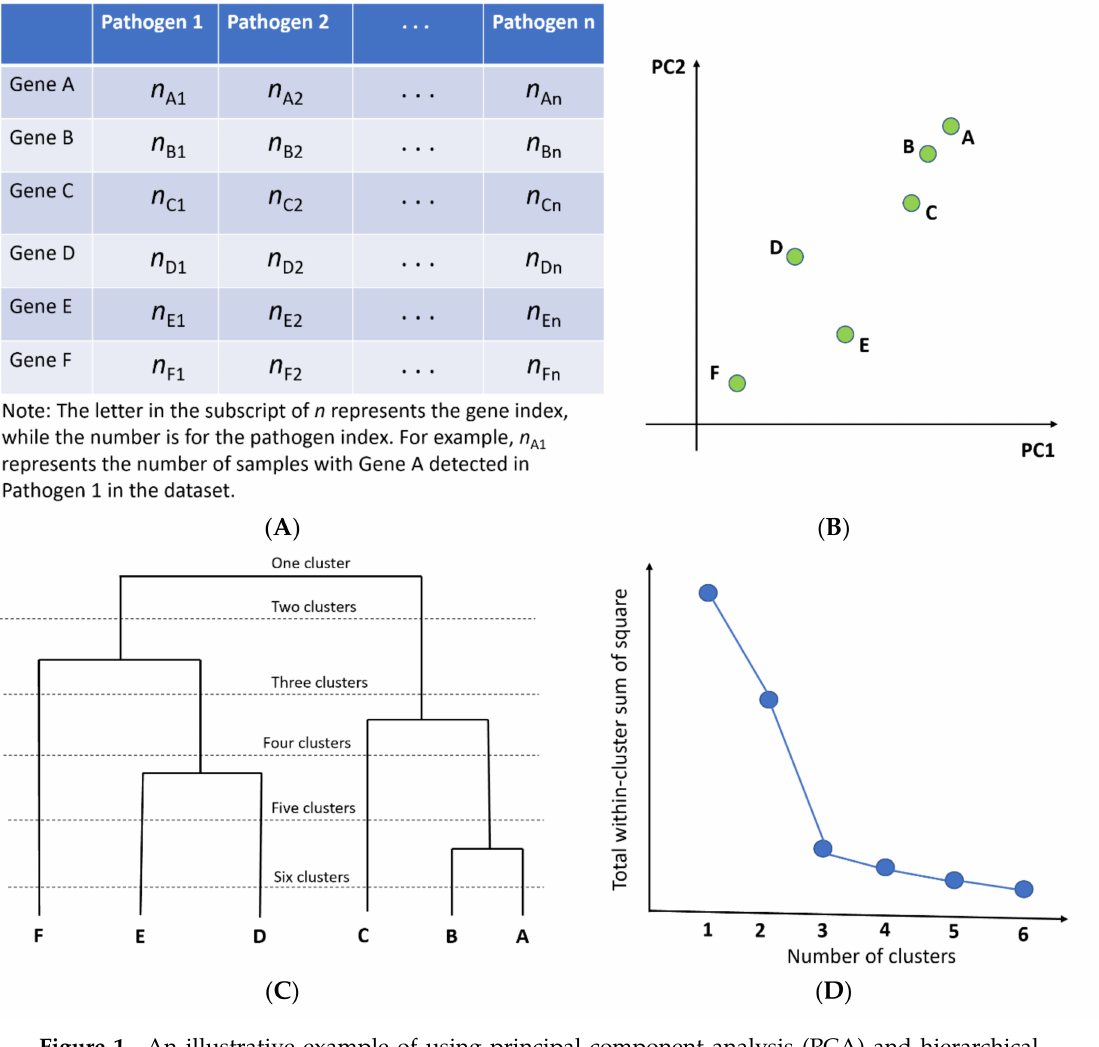
Figure 1. An illustrative example of using principal component analysis (PCA) and hierarchical clustering to identify important virulence genes: ( A ) a matrix was constructed with elements representing the number of the samples in which the gene in each row was detected in the pathogens in the columns; ( B ) genes from the high-dimensional matrix were projected onto the PC1~PC2 two-dimensional space; ( C ) the hierarchical clustering was used to group the data points on the basis of their projection onto the reduced dimensional space shown in ( B ); ( D ) the total within-cluster sum of square was calculated when the genes were grouped into one to six clusters (indicated by the dashed line in ( C ) in the dendrogram). A bend was observed when the genes were separated into three clusters, with F, ED, and ABC forming individual clusters, respectively. The clustering result was further confirmed by the genes’ projection on the PC1~PC2 space. While only six genes were used here for the purpose of illustration, a large number of genes with low occurrence patterns were typically lumped together such as genes A, B, and C in this work. The outlier genes such as genes F, E, and D were thus considered important